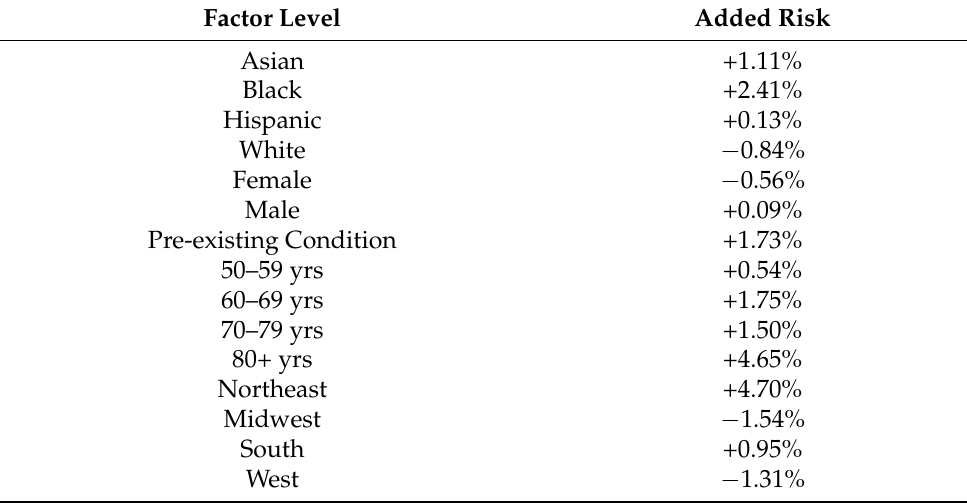
Table 12. Average added risk of mortality from COVID-19 for membership in a certain feature level, as compared to the overall mortality rate of 5.62%. Given as